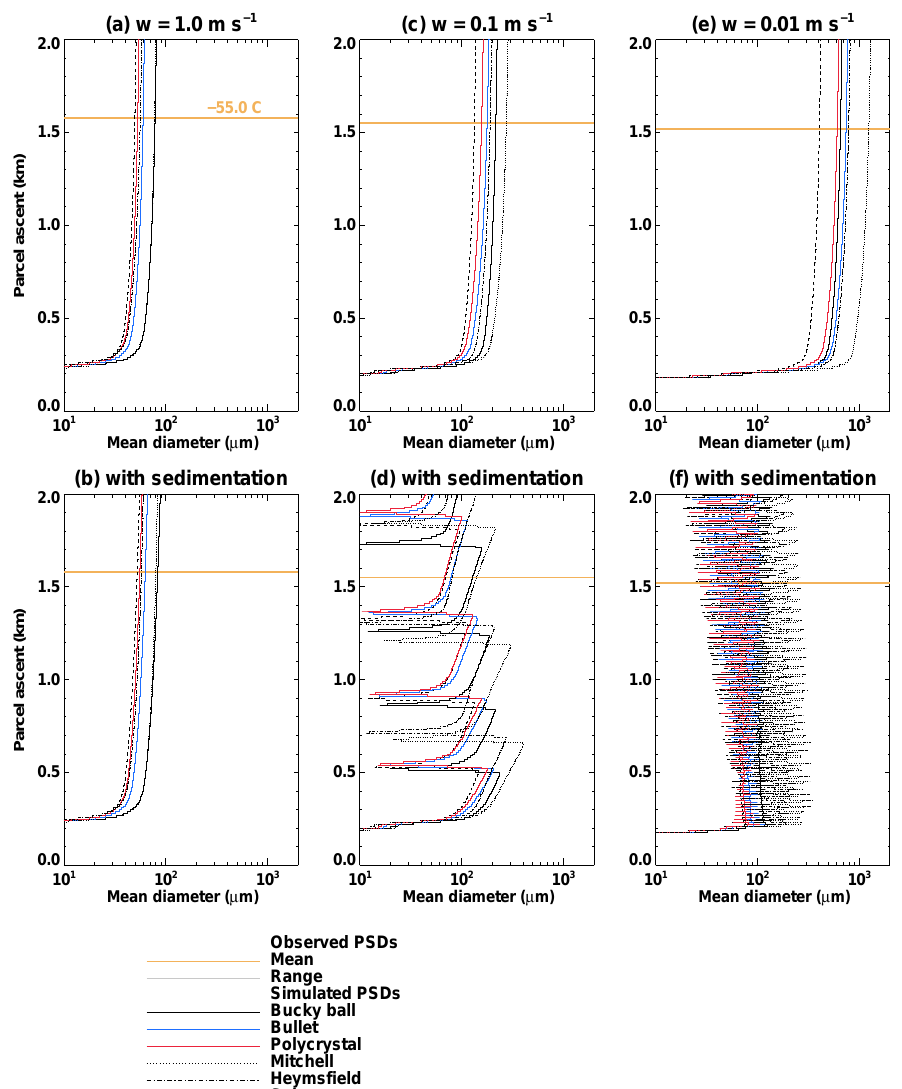
Figure 19. As in Fig. 18 except number-weighted mean ice crystal